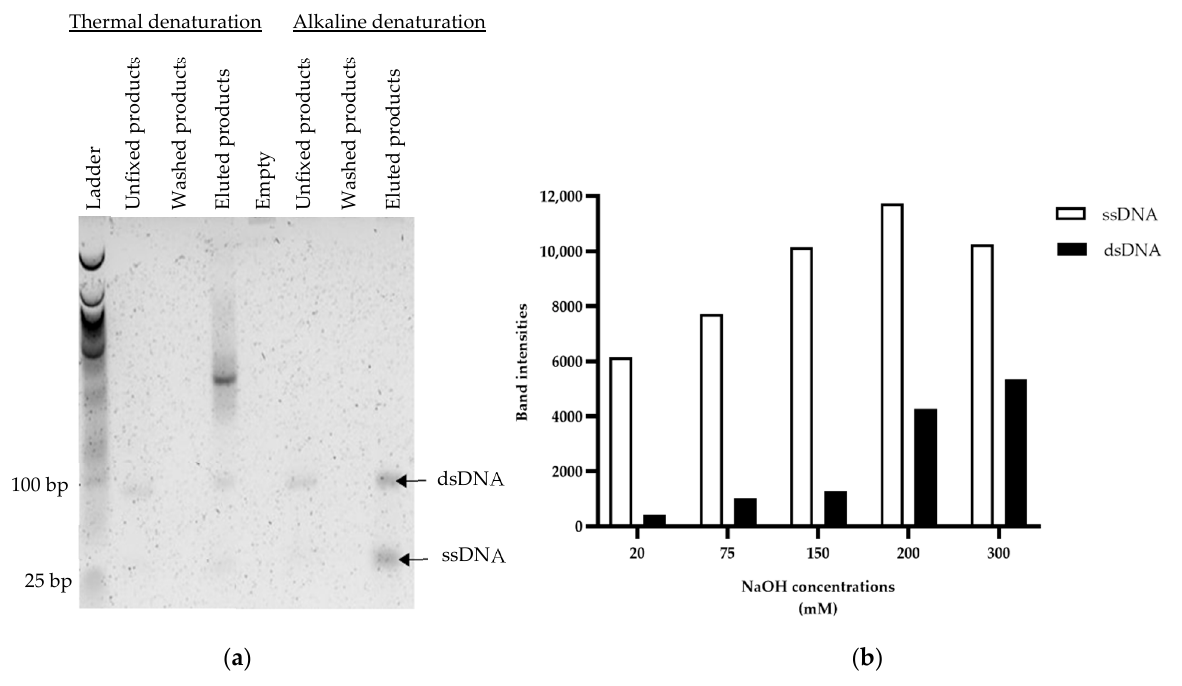
Figure 4. ( a ): Agarose gel electrophoresis (4% agarose, 90 V, 2 h in TAE 1× GelRed ® ) of eluted products following two elution methods (alkaline denaturation with 200 mM NaOH and thermal denaturation) with 20 mg of streptavidin-coated magnetic beads. ( b ): Representation of the band intensities (ImageJ), according to different NaOH concentrations tested (20, 75, 150, 200 and 300 mM NaOH) with 50 mg of beads. Band intensities represent the amount of ssDNA or dsDNA produced.